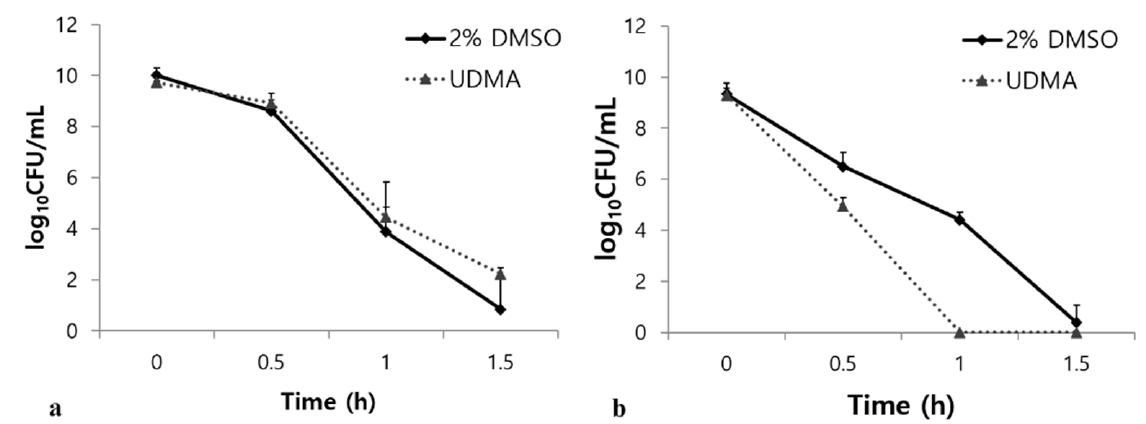
Figure 9. Bacterial responses of S. mutans UA159 grown in the presence and absence of UDMA to acidic stress ( a ), and oxidative stress ( b ). DMSO was used as a vehicle for UDMA, and cells grown in the absence of UDMA (2% DMSO) were used as the control.